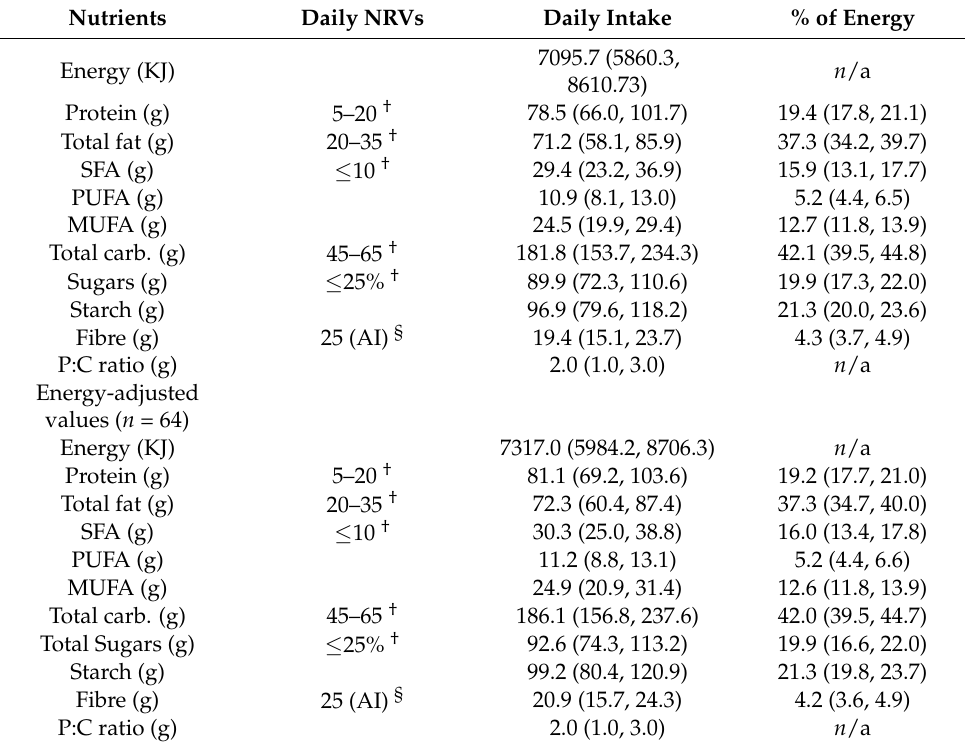
Table 2. Maternal dietary composition * during pregnancy ( n =